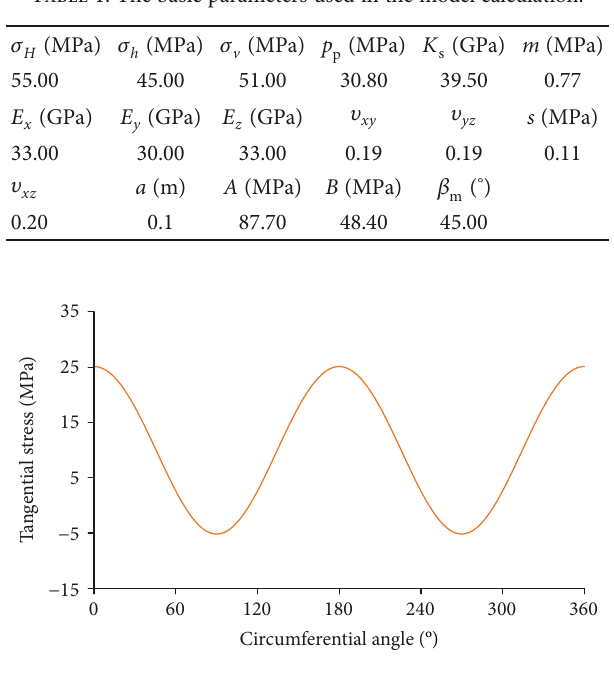
Figure 4: The relationship between tangential stress and circumferential angle.